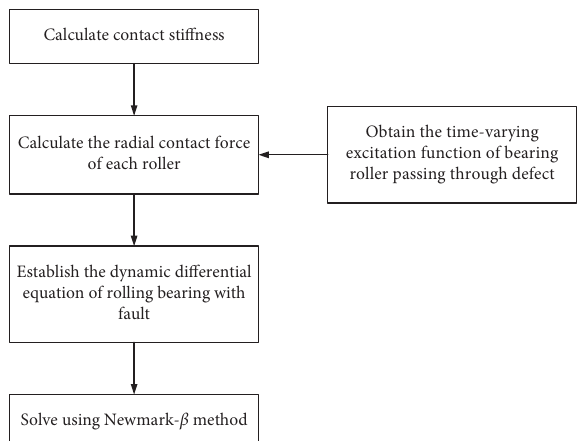
Figure 5: Calculation flowchart of the proposed dynamic model.